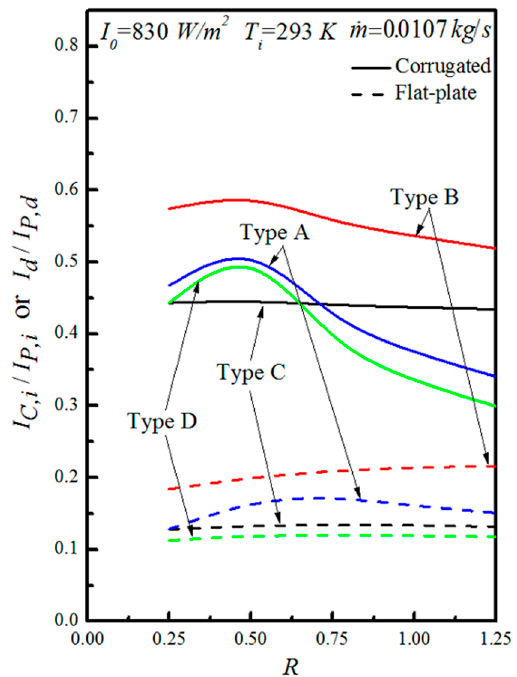
Figure 13. The ratio of the collector efficiency improvements and power consumption increments ( ṁ = 0.0107 kg/s).